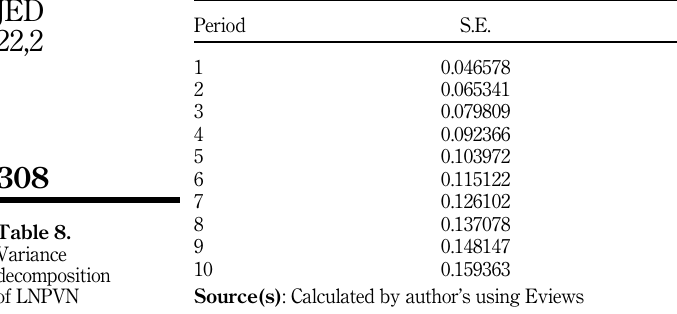
decomposition of